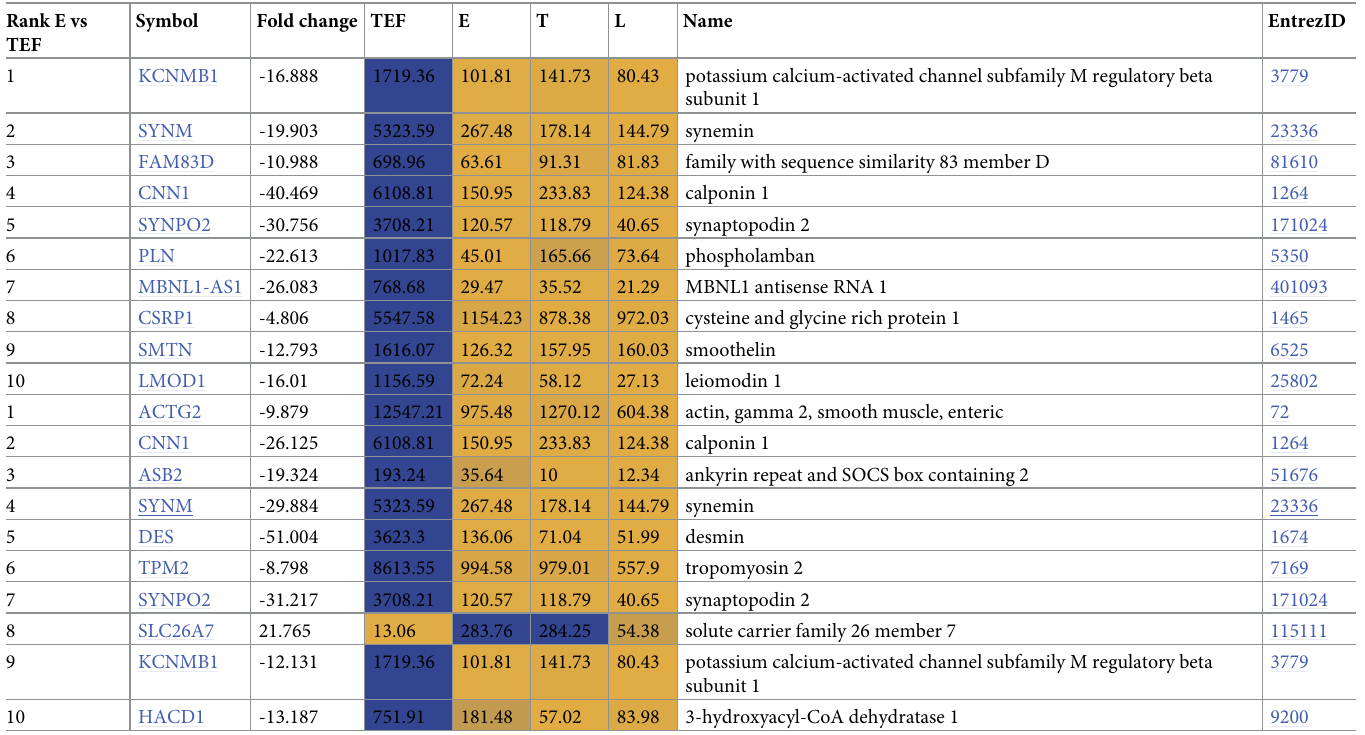
Table 2. Top10 differential expressed